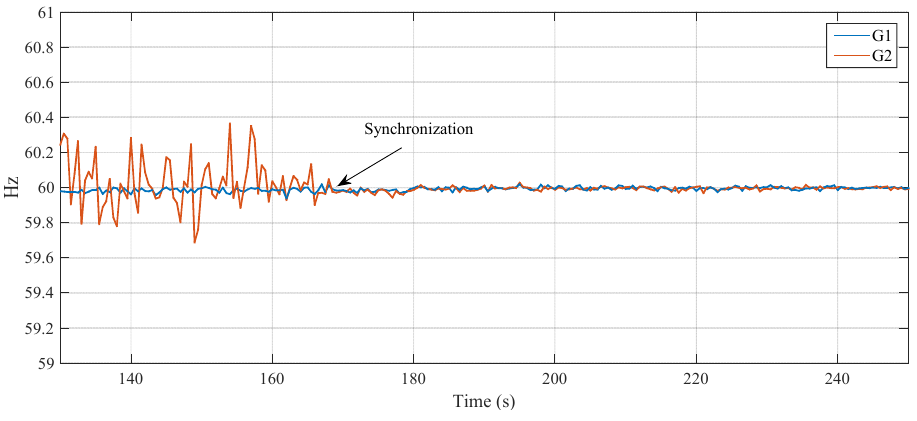
Figure 17. Generators frequencies.